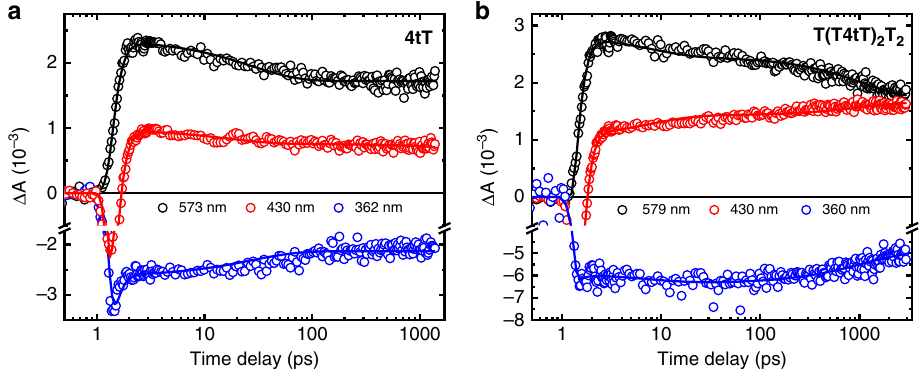
Fig. 5 Representative kinetic traces and fi ts at three probe wavelengths. Panel a shows kinetic traces for 4tT at the probe wavelengths of 573 nm (black), 430 nm (red), and 362 nm (blue), while panel b depicts kinetic traces for T(T4tT) 2 T 2 at the probe wavelengths of 579 nm (black), 430 nm (red), and 360 nm (blue). Both samples were dissolved in PBS solvent at pH 7.4 and excited at 340 nm. The raw data are represented with open circles, while the lines represent the best fi ts obtained from global and target analyses to the multidimensional transient-absorption data.